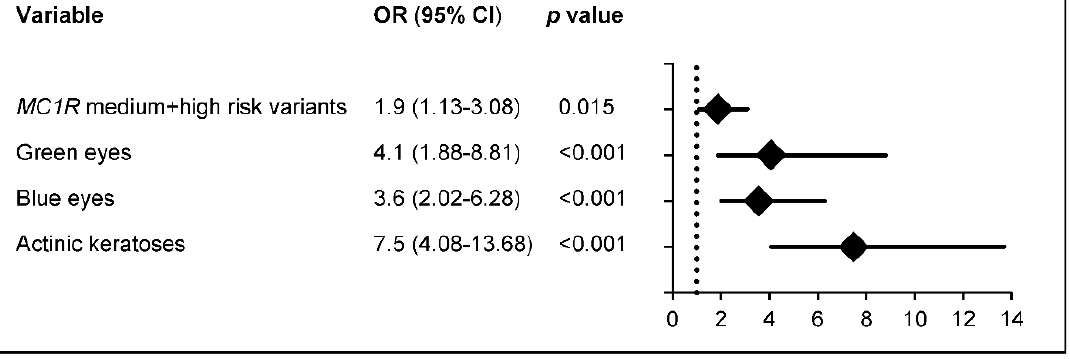
Figure 5. Multivariate logistic regression analysis for factors contributing to the risk of NMSC development. The x-axis represents the odds ratios (diamonds) and 95% confidence intervals (solid horizontal lines). The dashed vertical line indicates an OR value of 1 (no effect). Factors identified in multivariable models and significantly associated with NMSC development included blue eyes (OR: 3.6; 95% CI: 2.02–6.28; p < 0.001 ), green eyes (OR: 4.1; 95% CI: 1.88–8.81; p < 0.001), MC1R medium- + high-risk variants (OR: 1.9; 95% CI: 1.13–3.08; p = 0.015), and AKs (OR: 7.5; 95%